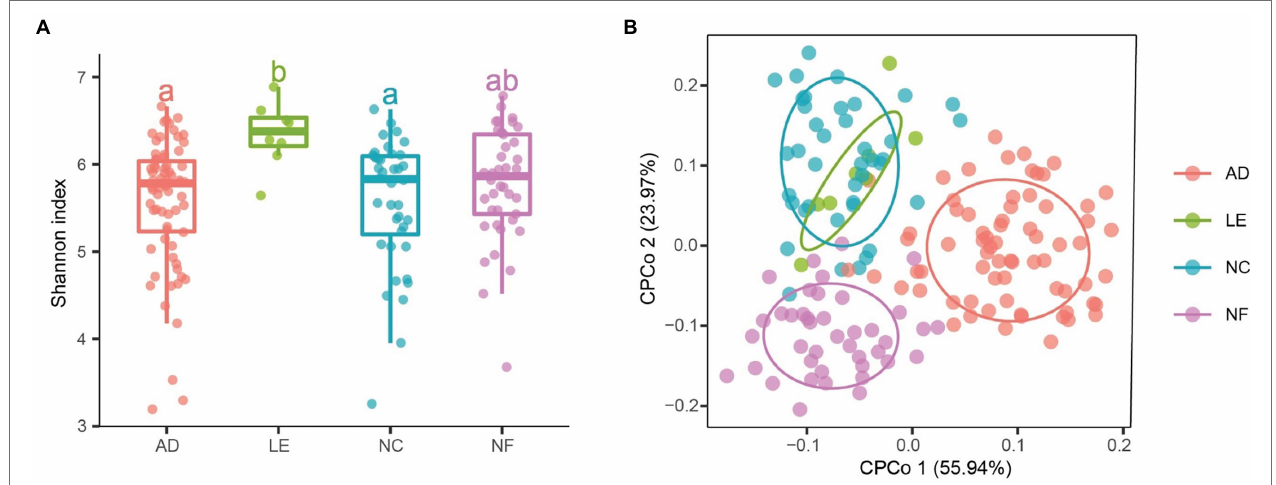
FIGURE 1 | Variation of gut microbial diversity of caecum fecal samples between four rodent species. (A) Alpha diversity (Shannon index). Different letters represent statistical significance ( p < 0.05). (B) Beta diversity comparisons of the gut microbiota of caecum fecal samples between the four rodent species. The first two axes are shown with constrained principal coordinate analysis (CPCoA) based on the Bray–Curtis dissimilarity matrix at the amplicon sequence variant (ASV) level. AD, Apodemus draco . LE, Leopoldamys edwardsi . NC, Niviventer confucianus . NF, Niviventer fulvescens